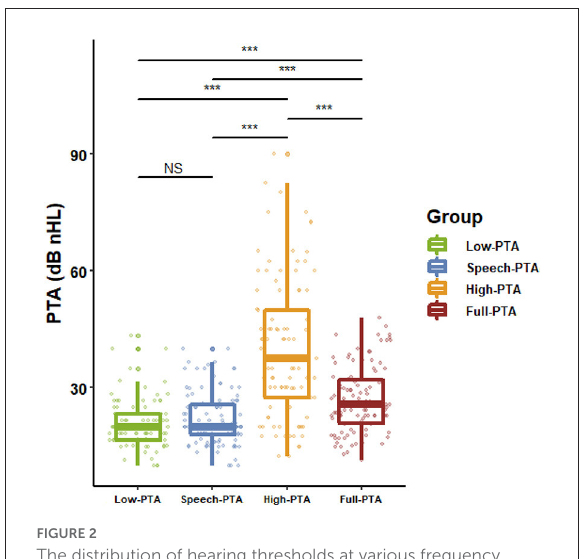
FIGURE2 The distribution of hearing thresholds at various frequency bands. Except for low frequency and speech frequency, the average values of PTA at all other frequency bands were significantly different ( n = 102, p < 0.001, 1-way ANOVA and Dunnet’s posttest). *** p < 0.001. NS: p >